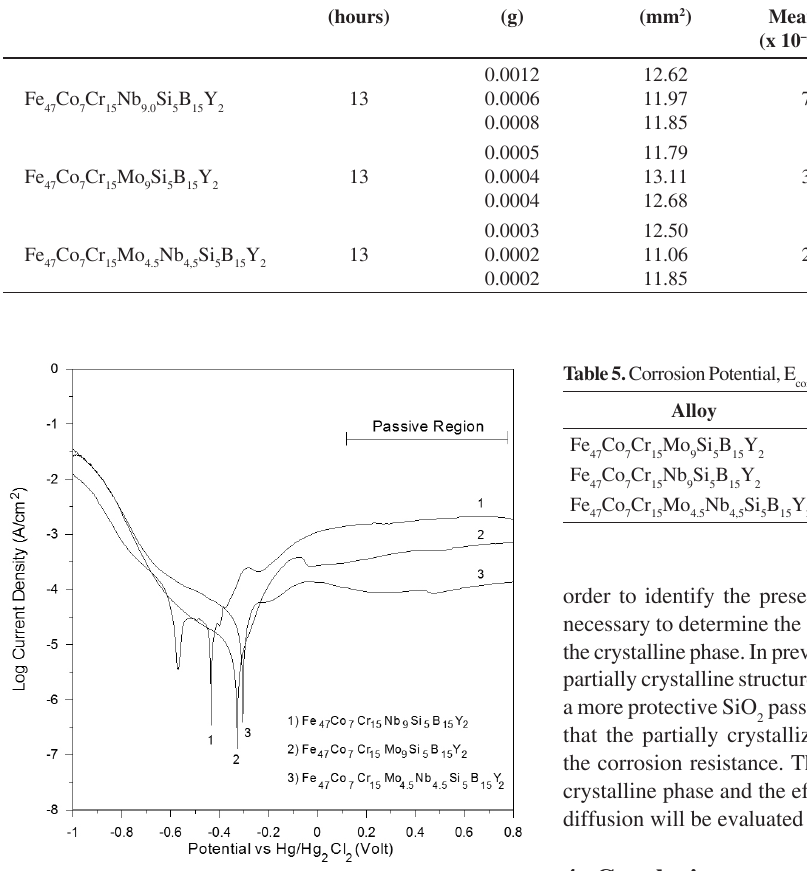
Figure 3. Potentiodynamic polarization curves of as-cast alloys in 4M HCl solution open to air, obtained at a scanning rate of 2 mVs −1